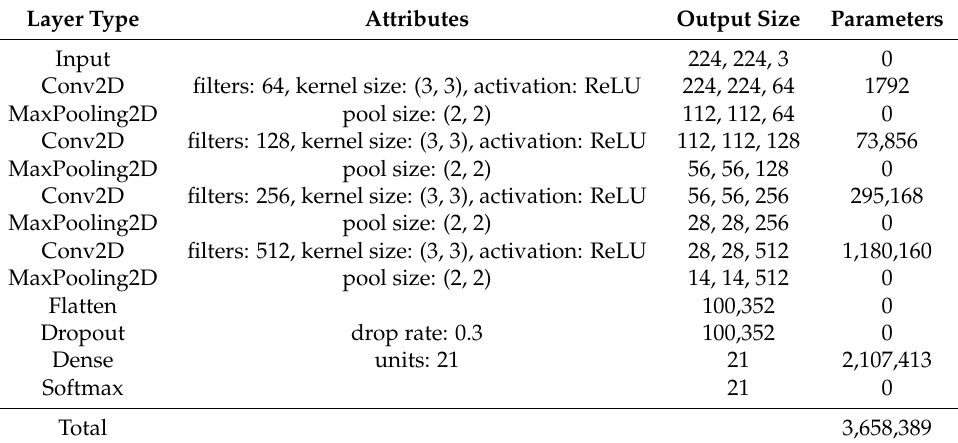
Table A2. The structure of the teacher CNN model in experiments on UCMerced